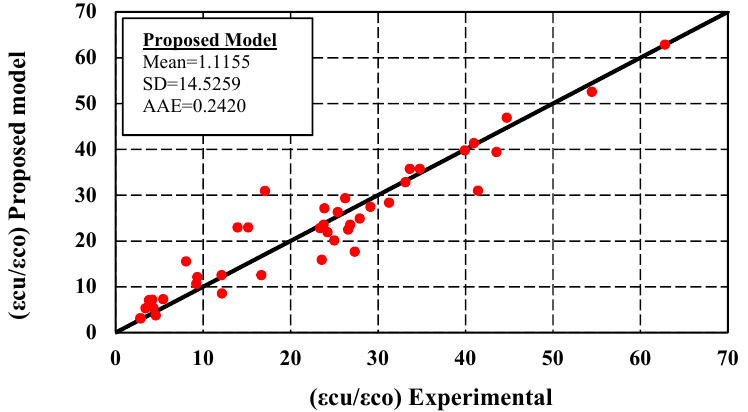
(cid:2965) (cid:3179)(cid:3170)(cid:3178) Figure 16. Comparison of ε ult Figure 16. Comparison of values obtained from the proposed model (Equation (20e)) and ex- ε co values obtained from the proposed model (Equation (20e)) and (cid:3084) (cid:3278)(cid:3290) experimental perimental data.